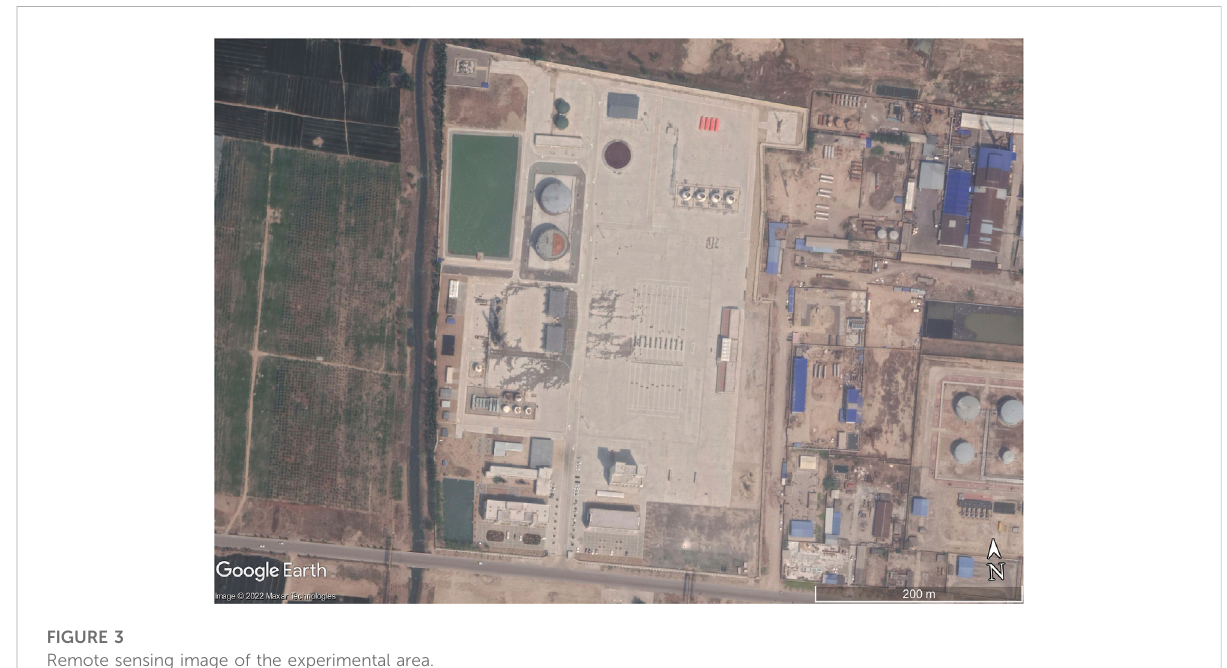
FIGURE 3 Remote sensing image of the experimental area.